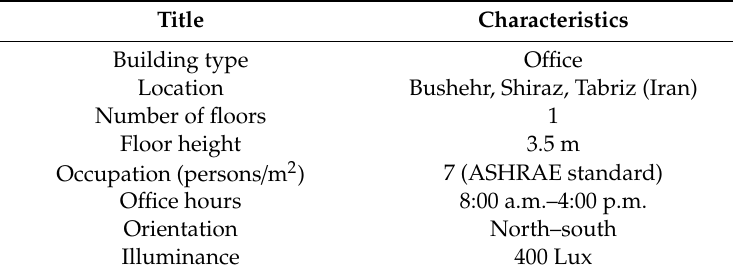
Table 2. Characteristics of the case study.